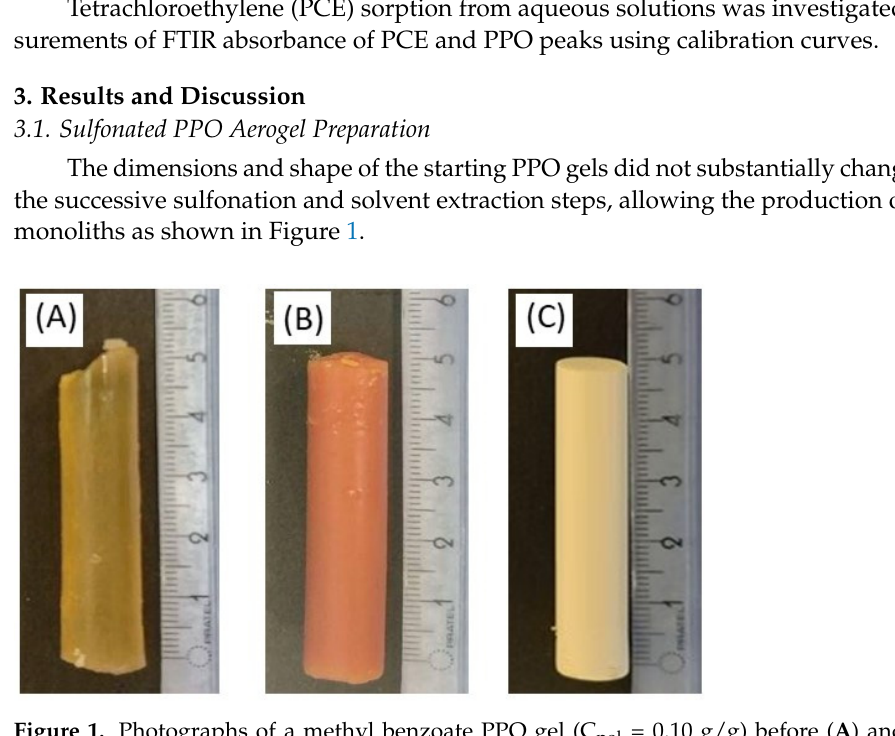
Figure 1. Photographs of a methyl benzoate PPO gel (C pol = 0.10 g/g) before ( A ) and after ( B ) sulfonation, and of the corresponding sulfonated aerogel ( C ) obtained after scCO 2 solvent extraction (units of the ruler: cm).